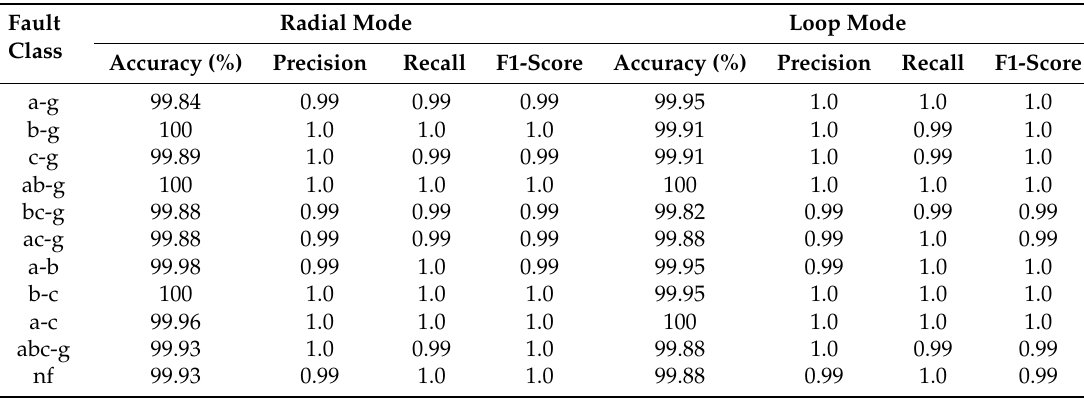
Table 4. Precision, recall, F1-score, and individual class accuracy of the proposed classifier for islanded radial mode and islanded loop mode